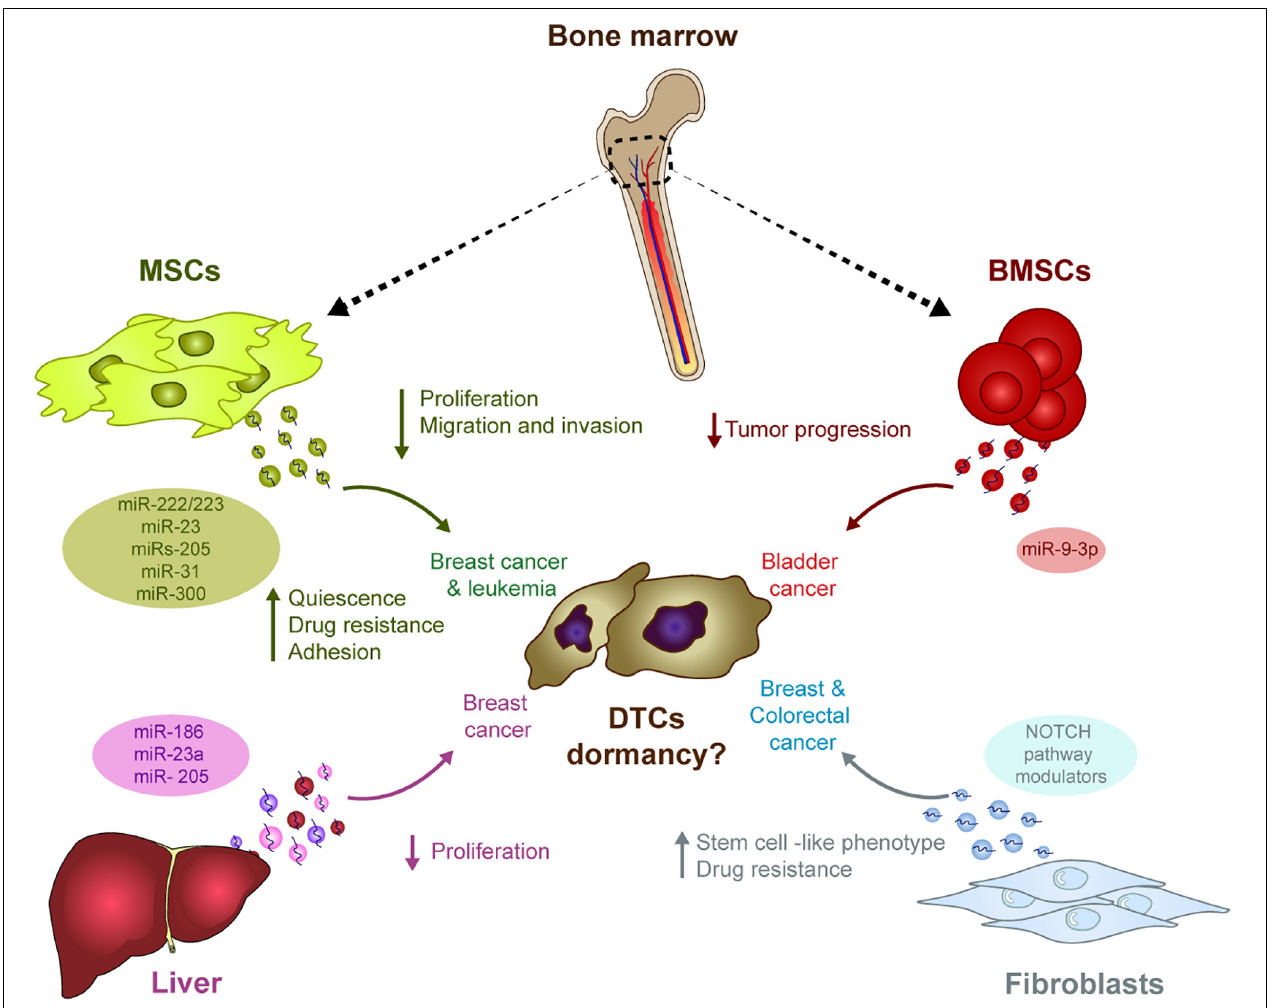
FIGURE 1 | The influence of stromal-derived EVs in tumor cell dormancy. EVs generated in different stromal cells may have the ability to induce DTC dormancy in diverse tumor types. The transport of miRNA in these EVs outstand as one of the main mechanism potentially involved in this process: In the bone marrow, MSCs-derived EVs contain different miRNAs capable of modulating several pro-dormant features (e.g., quiescence, reduced proliferation, etc.) in breast cancer cells, whereas miRNAs in BMSCs-derived EVs suppress progression of bladder cancer. In the liver, several miRNAs in hepatic niche-derived EVs reduced breast cancer cell proliferation. Finally, miRNAs in EVs derived from fibroblasts induce a stem cell like phenotype and resistance to therapy in breast and colorectal cancer